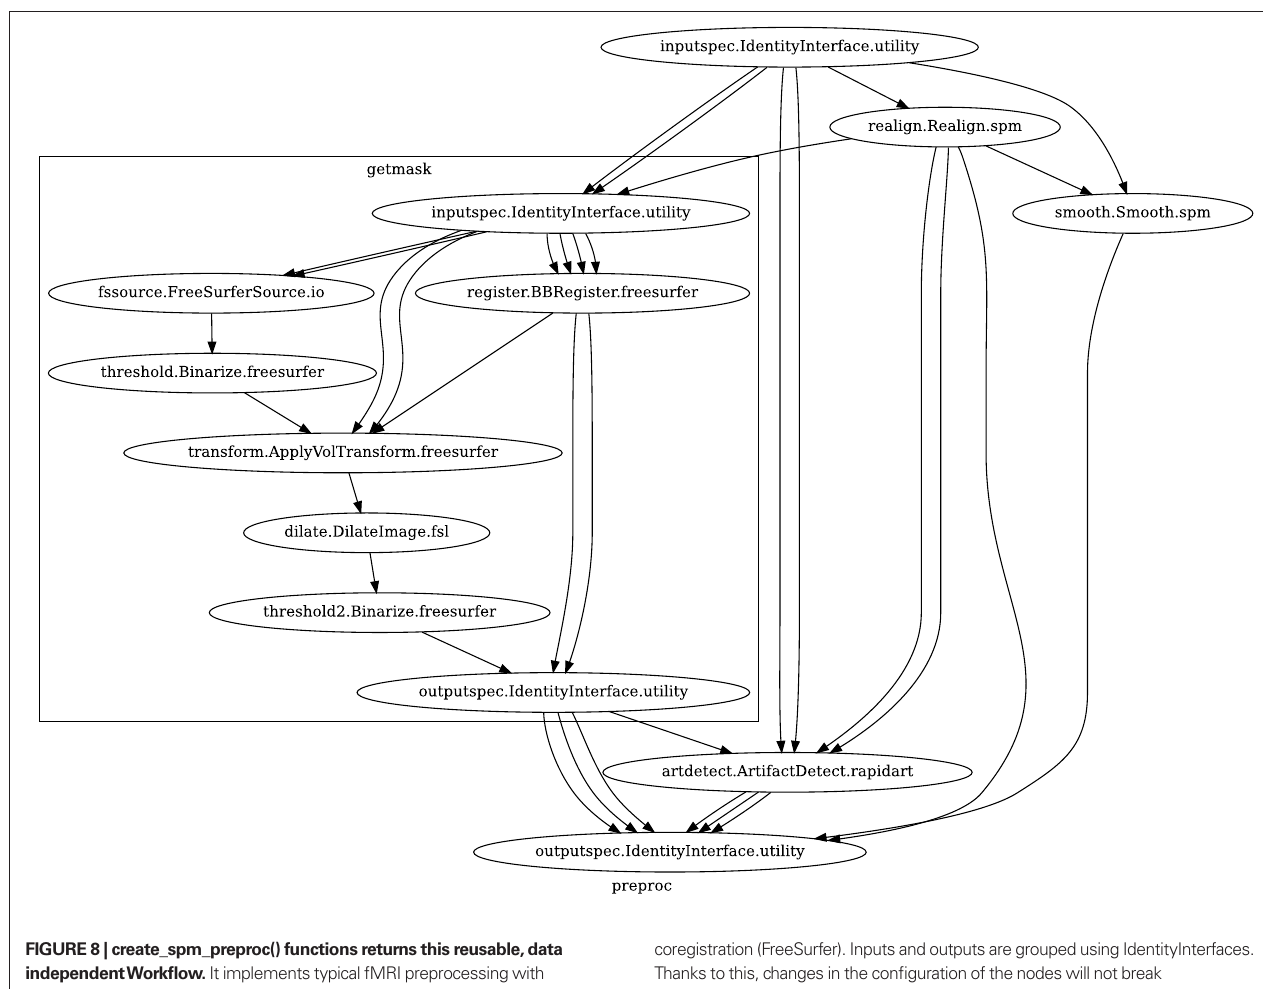
FiGure 8 | create_spm_preproc() functions returns this reusable, data independent Workflow. It implements typical fMRI preprocessing with smoothing (SPM), motion correction (SPM), artifact detection (Nipype), and